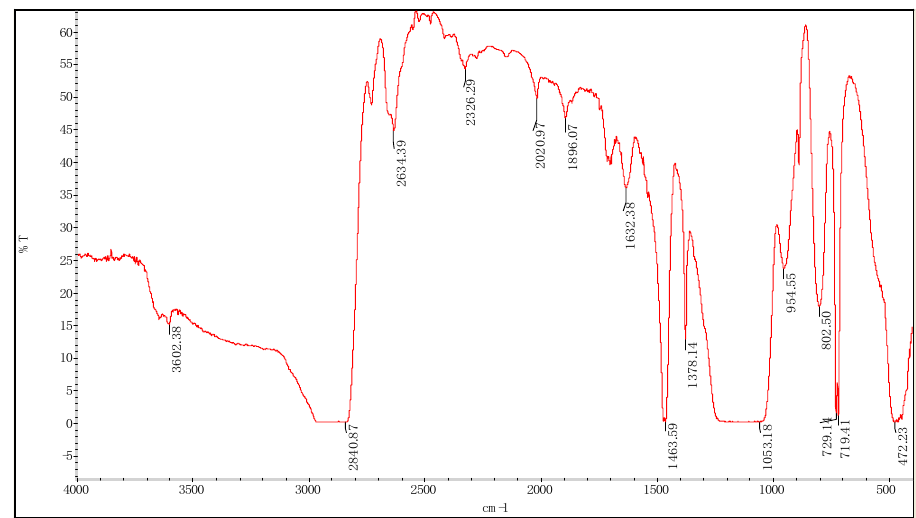
Figure 12. Fourier Transform Infrared Spectra of Silica (Modified) Particles.